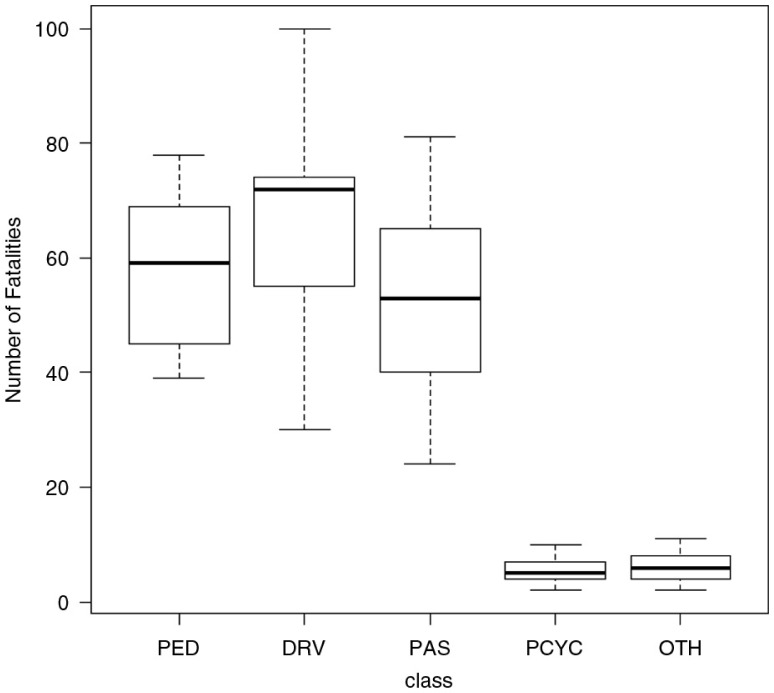
Boxplot of road traffic fatalities in Trinidad and Tobago by class (data from 2000 to 2011). PED, Pedestrian; DRV, Driver; PAS, Passenger; PCYC, Motor bikes; OTH, Others.